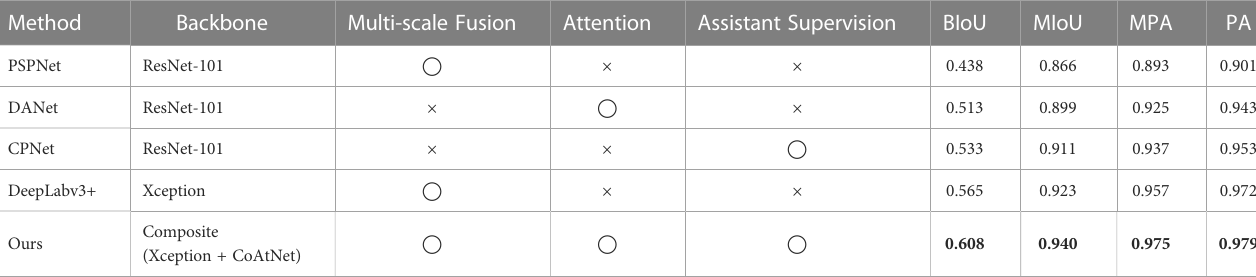
TABLE 4 The performance of segmentation Models in fi ne-tuning training.